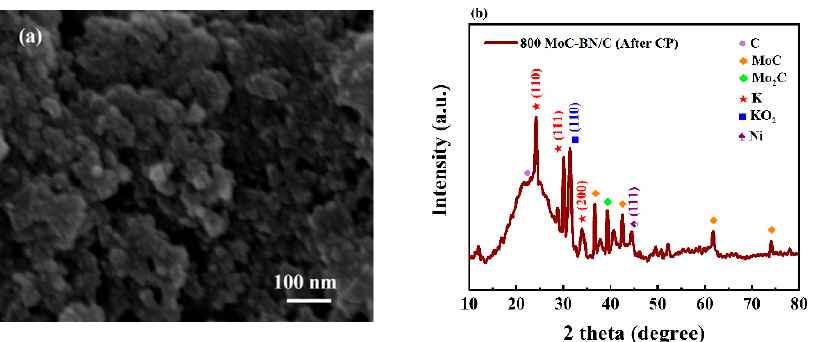
Figure 5. ( a ) SEM image of 800 MoC-BN/C after OER, ( b ) XRD pattern of 800 MoC-BN/C after OER . 3. Materials and